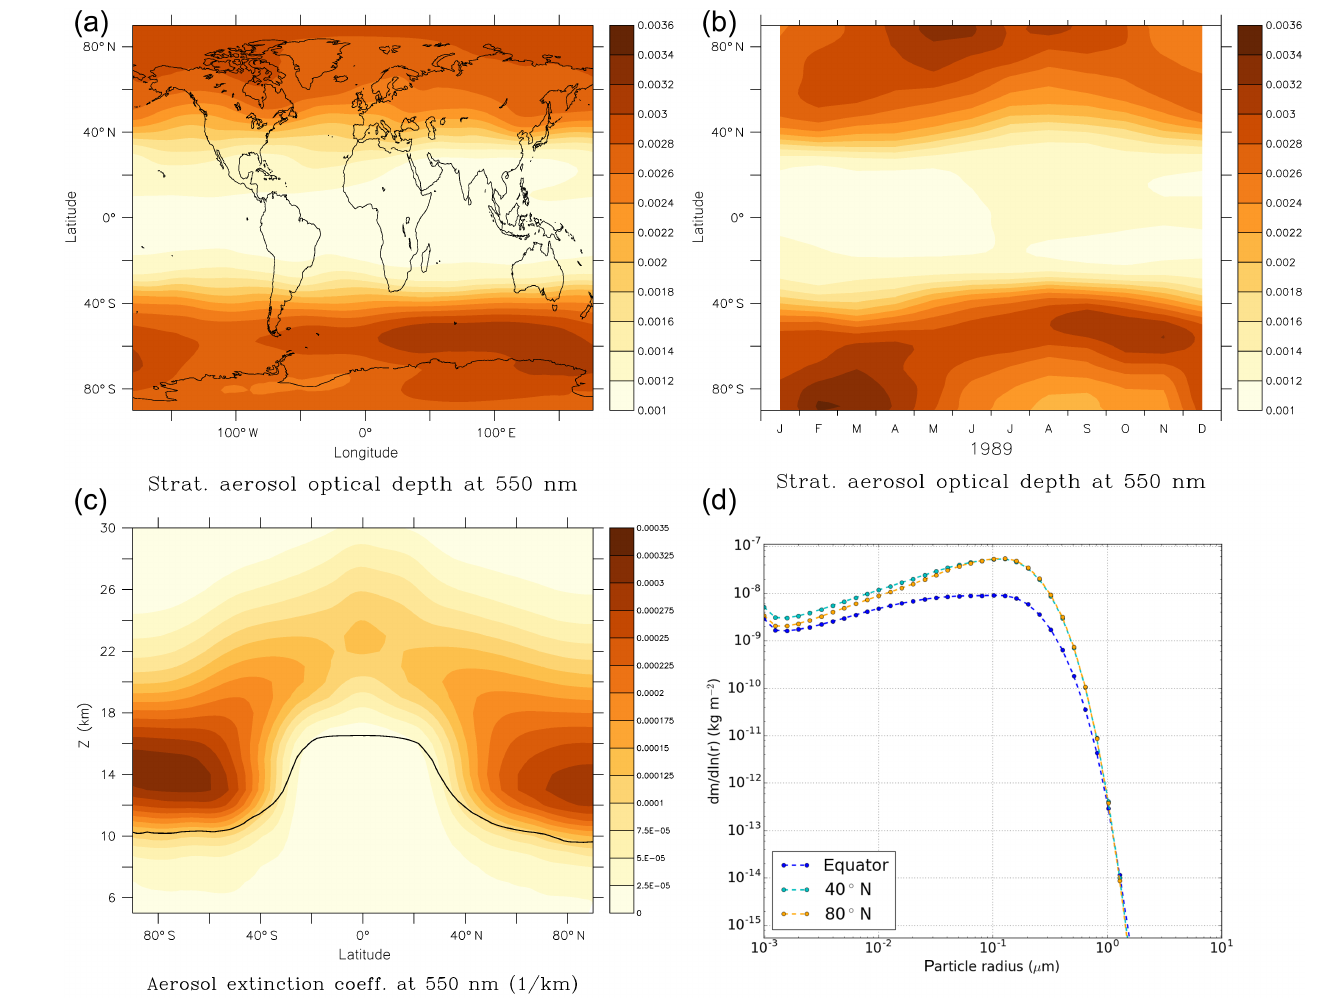
Figure 4. (a) Annual mean latitude–longitude distribution of the stratospheric AOD at 550nm. (b) Zonal mean latitude–time distribution of the stratospheric AOD at 550nm. (c) Zonal mean latitude–height distribution of the stratospheric aerosol extinction coefficient (km − 1 ) at 550nm. (d) Mass size distribution at different latitudes (in kgm − 2 ). All variables are from the 10th year of the simulation with no volcanic input in the stratosphere and are assumed to represent a steady